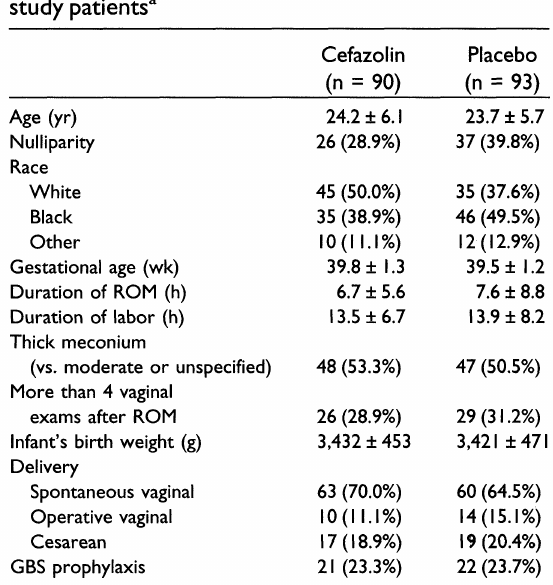
TABLE I. Demographic and clinical profile of study patients